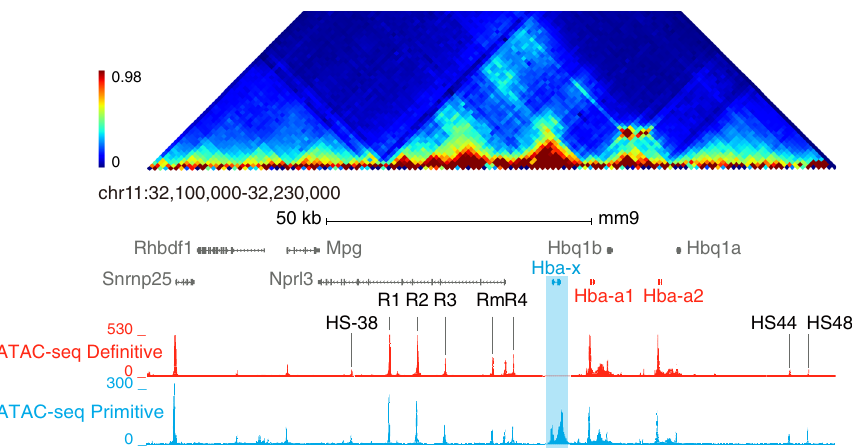
Fig. 1 Chromatin environment at the α -globin locus. Upper panel, Tiled-C interaction map showing interactions across the α -globin locus in de fi nitive erythroblasts 16 . Lower, normalized (RPKM) ATAC-seq tracks from primary primitive (blue) and de fi nitive (red) erythroid cells; these were merged from three independent experiments where three litters (primitive) or three fetal livers (de fi nitive) were analyzed in total. The α -globin enhancers (R1 – R4;Rm) and the fl anking CTCF sites (HS-38, and HS-44;HS-48) of the α -globin gene cluster are indicated. In primitive cells, hypersensitivity is observed over the Hba-x gene; the other elements within the gene cluster are unchanged compared to de fi nitive erythroid